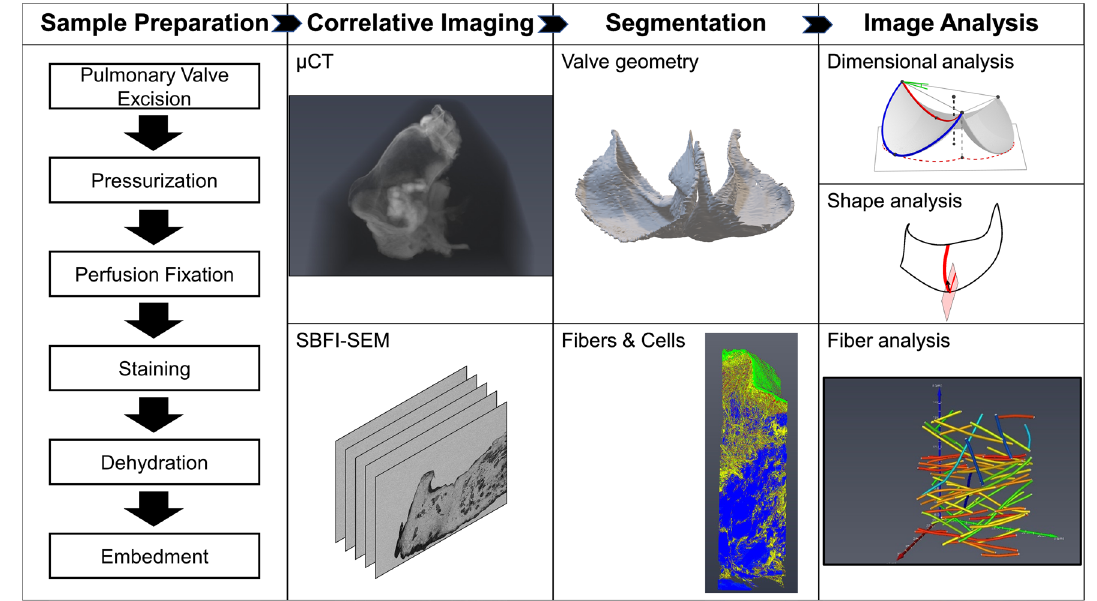
Figure 1. Flow chart describing the workflow for correlative imaging and